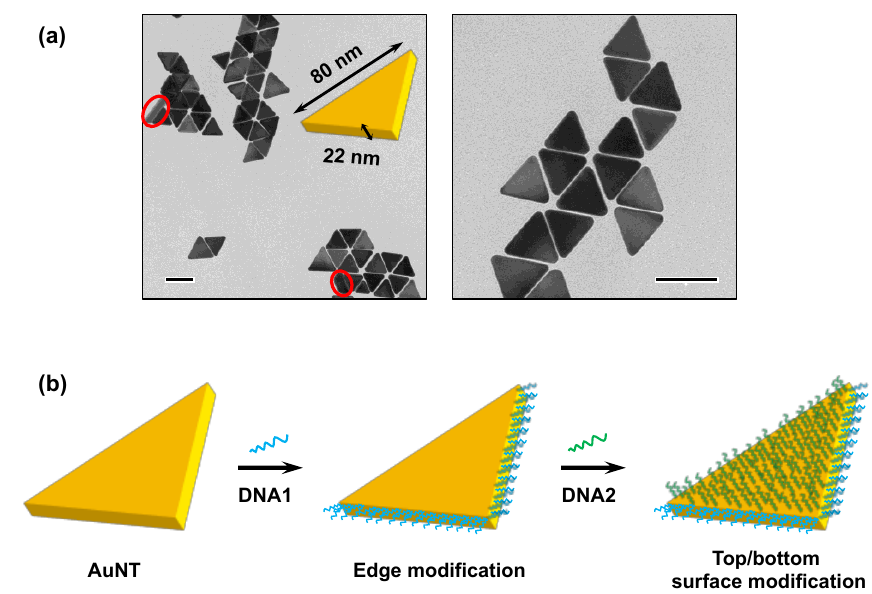
Figure 2. Characterization and surface modification of the AuNTs. ( a ) Typical TEM images of the seedless grown AuNTs. Red circles highlight the AuNTs standing vertically on the TEM microgrid. Scale bars are 100 nm. ( b ) Regioselective DNA modification of AuNT by successive addition of DNA1 and DNA2.